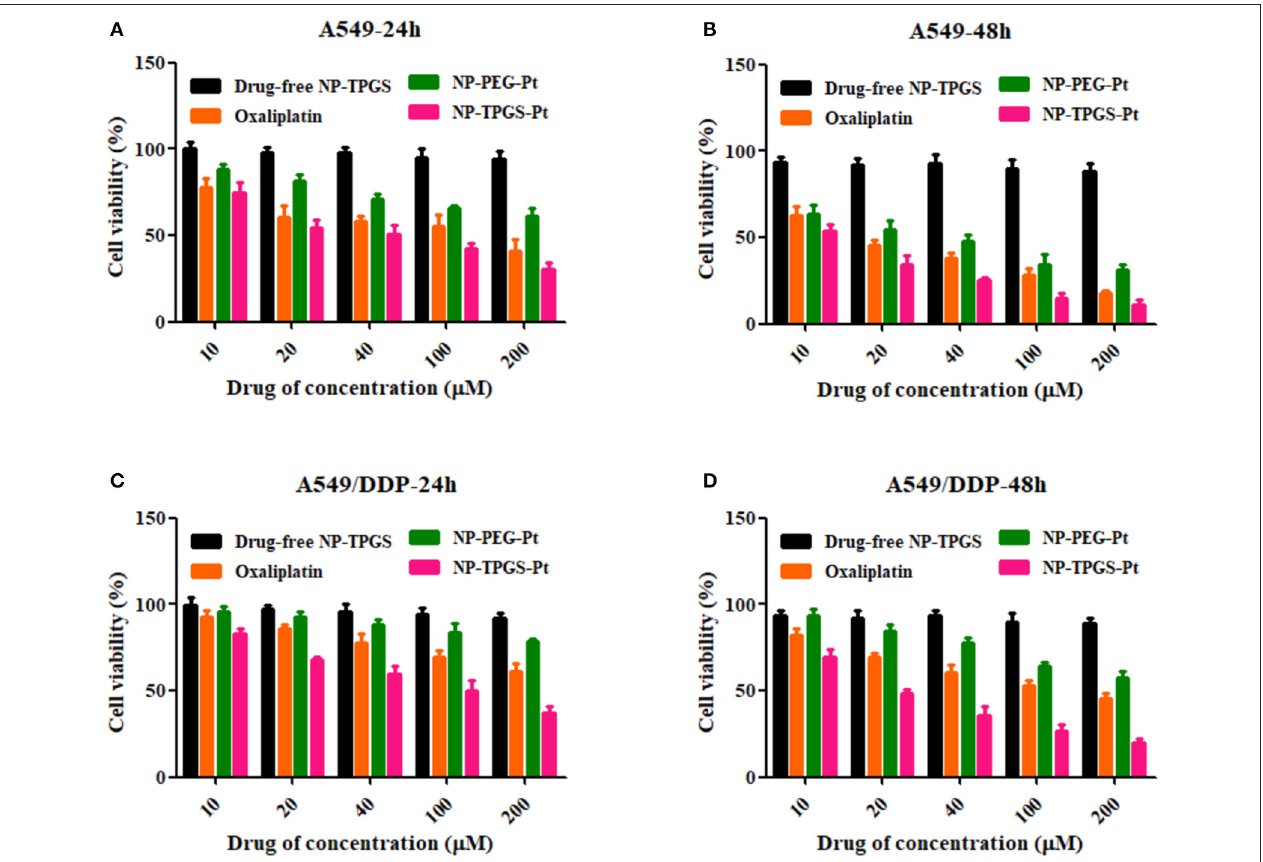
FIGURE 7 | Cell viability of A549 and A549/DDP cells incubated with the TPGS/DACHPt compared with that of oxaliplatin, NP-PEG-Pt and NP-TPGS-Pt at the same Oxaliplatin dose and that of the drug-free TPGS with the same polymer concentrations: (A,B) A549 cells for 24 and 48h. (C,D) A549/DDP cells for 24 and 48h.